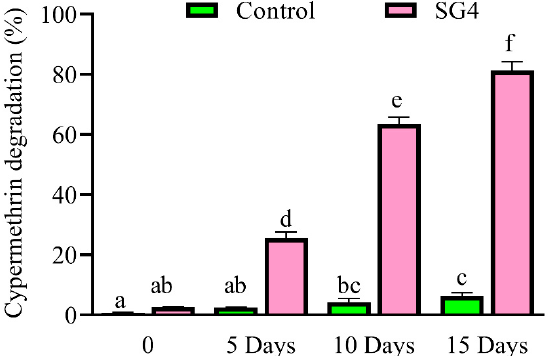
Figure 3. Cypermethrin degradation in soil slurry with strain SG4. The data presented are mean ± standard errors of three independent experiments. Statistical analysis was performed by one way ANOVA of Duncan method, and di ff erent letters indicate significant di ff erences ( p < 0.05) between